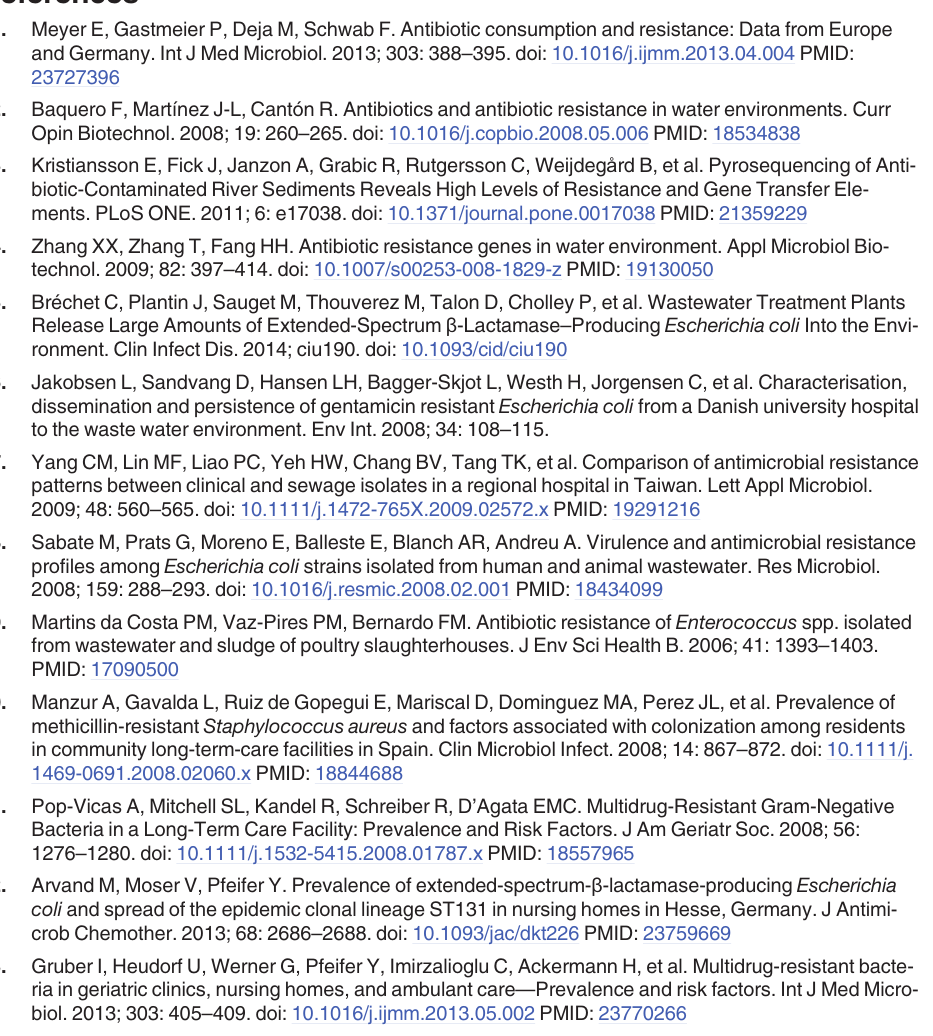
S4 Table. Abundance and Identity of detected plasmid sequences. Assigned high-throughput sequencing reads/contigs of the samples C1754, C1755, C1756 and C1757 against the RefSeq